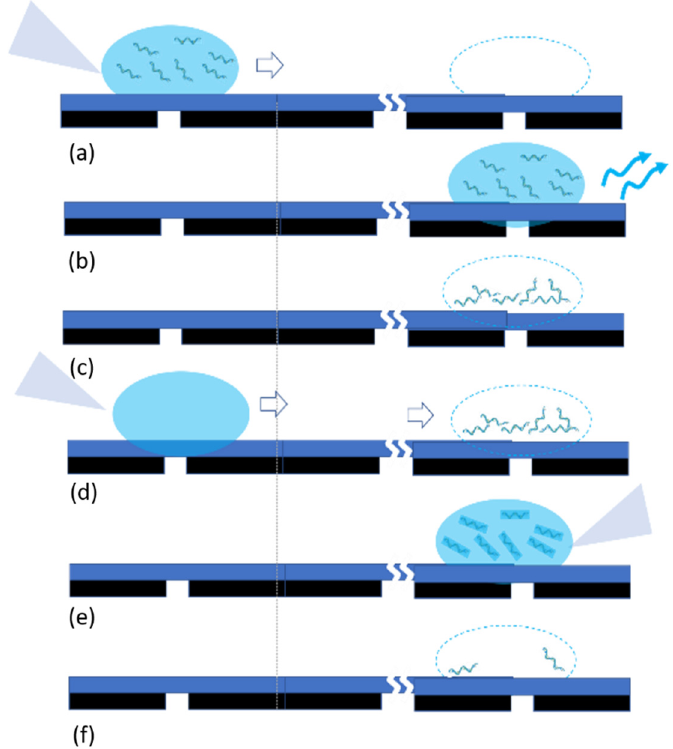
Figure 2. The principle of DMF-based DNA storage includes: ( a ) Adding a DNA droplet on DMF; ( b ) Moving to the target position; ( c ) Dehydration of the DNA droplet; ( d ) Putting a water droplet on DMF; ( e ) Taking the retrieved DNA; The residue on the DMF is the ( f ) non-retrieved DNA.